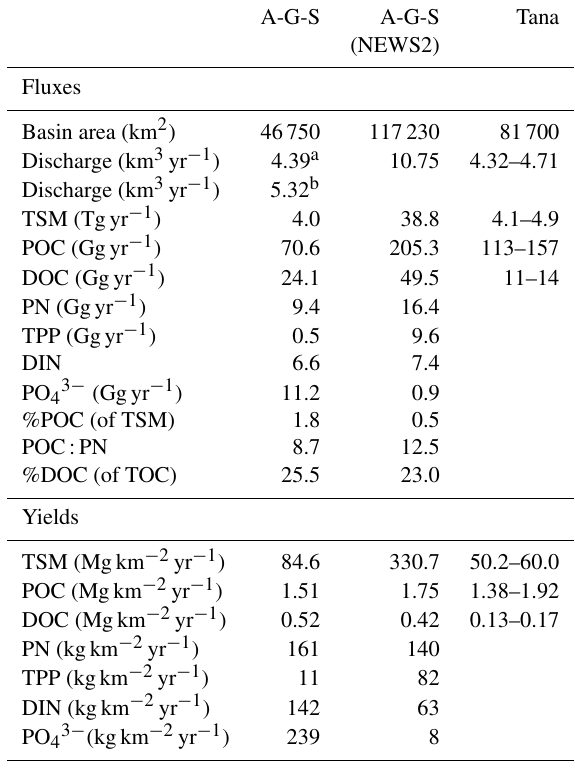
Table 1. Summary of annual fluxes, element ratios and annual yields for the Athi–Galana–Sabaki River basin from data reported here and from the NEWS2 export model (see Mayorga et al., 2010), as well as data for 2012 and 2013 from the neighbouring Tana River basin at Garsen (Geeraert et al.,